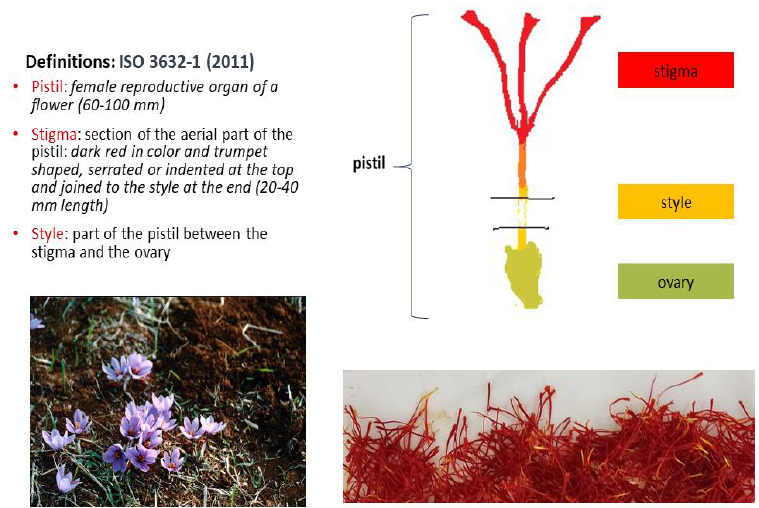
Figure 1. Photos of saffron plants and pistils (M.Z.T. personal collection), female organ and definitions of traded plant material according to the relevant ISO standard [1].